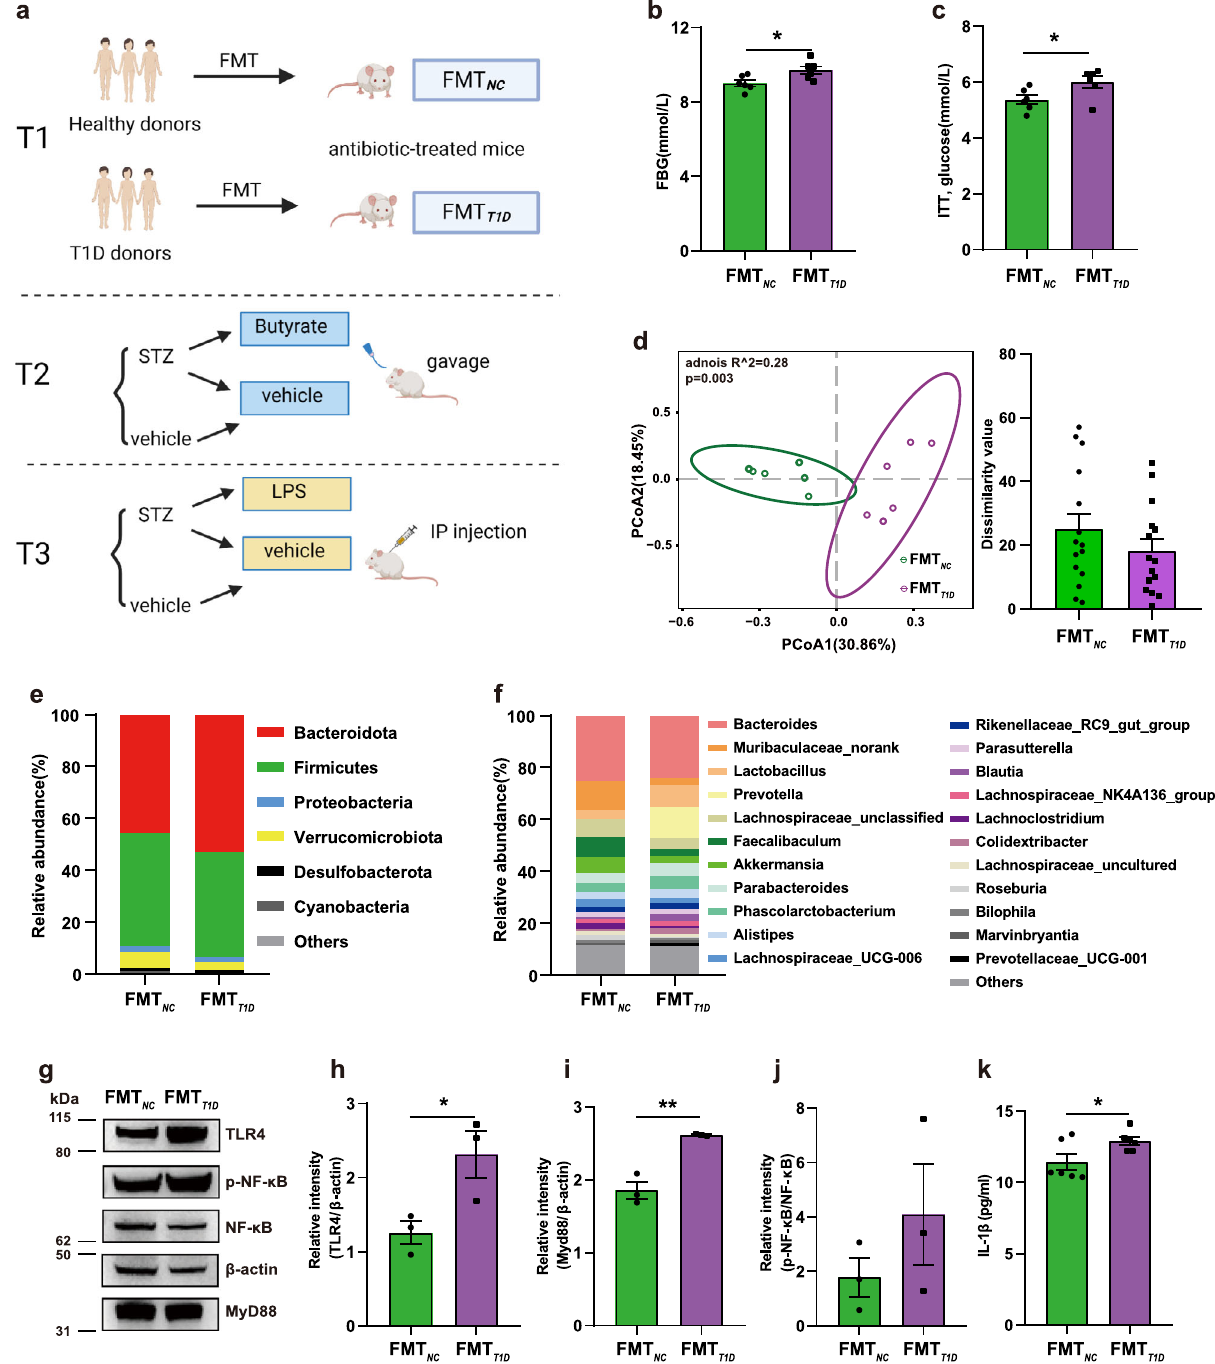
Fig. 5 | Disturbed glucose homeostasis induced by the transplantation of T1D- associated gut microbiota. a Schematic diagram of the study design. b Fasting blood glucose level ( p =0.025). c Glucose levels at 30min after insulin injection in theITT( p =0.040). d PCoAplotbasedontheBray-Curtisdistances(left)andinner- group distance by ANOSIM analysis (right). e , f Microbial composition at the phy- lum ( e ) and genus ( f ) level. g Western blotting results depicting the TLR4, Myd88, and p-NF- κ B protein expression levels in the liver. h – j Quanti fi cation of band